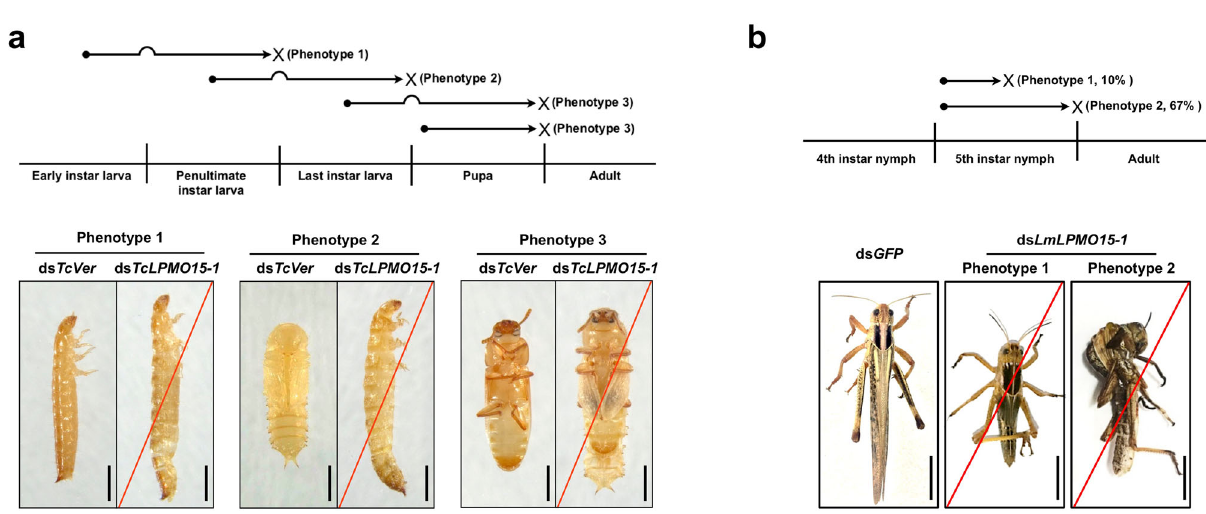
Fig. 3 Enzymatic properties of r Of LPMO15-1. a SDS-PAGE analysis. r Of LPMO15-1 protein obtained by β -chitin bead af fi nity chromatography was subjected to electrophoresis on a 15% SDS-PAGE and stained with Coomassie Brilliant Blue R-250. b Enzymatic activity. r Of LPMO15-1 (1 μ M) was incubated with 5 mM 2,6-DMP and 100 μ M H 2 O 2 in 100 mM sodium phosphate (pH 6.0) at 30 °C. The absorbance at 469 nm was measured every 30 s up to 600 s (red dots). The same assay without r Of LPMO15-1 was performed as a negative control (blue dots). c – f LPMO substrate speci fi city testing with β -chitin and cellulose. r Of LPMO15-1 (1 μ M) was incubated with 2 mg/ml β -chitin ( c ) or microcrystalline cellulose ( d ) in 20 mM sodium phosphate buffer (pH 6.0) containing 1 mM ascorbic acid at 30 °C for 24 h followed by centrifugation at 17,000 × g . The supernatants were analyzed by MALDI-TOF/TOF mass spectrometry. The same assays with β -chitin without r Of LPMO15-1 ( e ) or ascorbic acid ( f ) were performed as negative controls. g The reducing sugar generated by the LPMO-chitinase system. Each reaction mixture contained 2 mg/ml β -chitin, 5 μ M r Of LPMO15-1 and/or 1 μ M r Of Chi-h in 20 mM sodium phosphate buffer (pH 6.0). An extra of 1 mM ascorbic acid was added in the presence of r Of LPMO15-1. “ r Of LPMO15-1 + r Of Chi-h ” indicates the calculated sum of the reducing sugar generated by the individual enzymes. The “ r Of LPMO15-1 & r Of Chi-h ” indicates the reducing sugar produced by combining these two enzymes in the reaction. h Relative product quanti fi cation showing the synergistic effect between r Of LPMO15-1 and r Of Chi-h. Each reaction mixture contained 2 mg/ml β -chitin, 1 mM ascorbic acid, 5 μ M r Of LPMO15-1 and/or 1 μ M r Of Chi-h in 20 mM sodium phosphate buffer (pH 6.0). The soluble products generated were quanti fi ed by HPLC. The soluble products generated by r Of LPMO15-1 alone was fi rst degraded by r Of Chi-h and then quanti fi ed by HPLC. Chitobiose was the main product generated from chitin degradation, so that the synergistic effect was calculated according to the amount of chitobiose in each sample. All data are shown as the mean value ± SE ( n = 3).